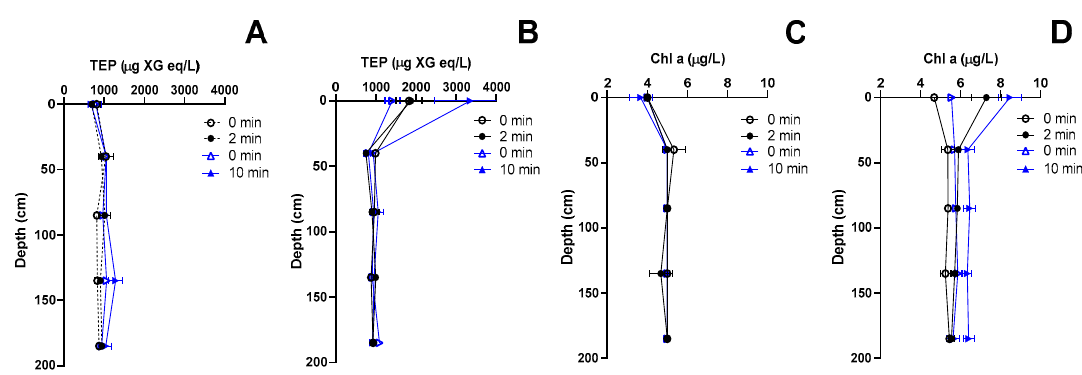
Figure 4. Depth profiles for TEP ( A , B ) and Chl a ( C , D ) from natural enrichment experiments ( A , C ) without bubbling and bubble-derived enrichment experiments ( B , D ).